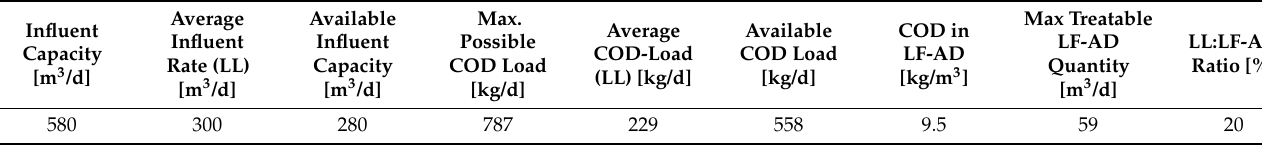
Table 2. Available free influent capacities for LF-AD in the LLTP.